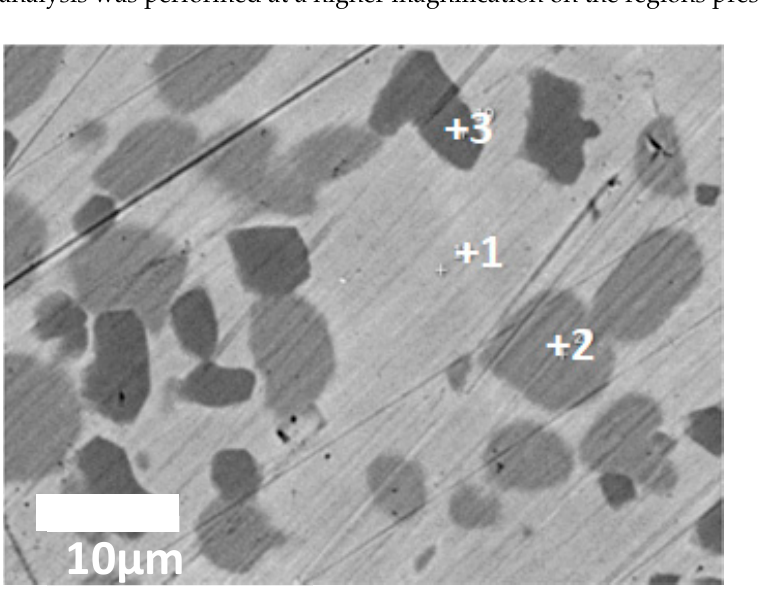
Figure 2. BSE micrograph of as-cast Ti 0.3 V 0.3 Mn 0.2 Fe 0.1 Ni 0.1 alloy. In this micrograph, the matrix, grey, and dark grey phases are indicated by points number 1, 2, and 3, respectively. Their chemical composition is listed in Table